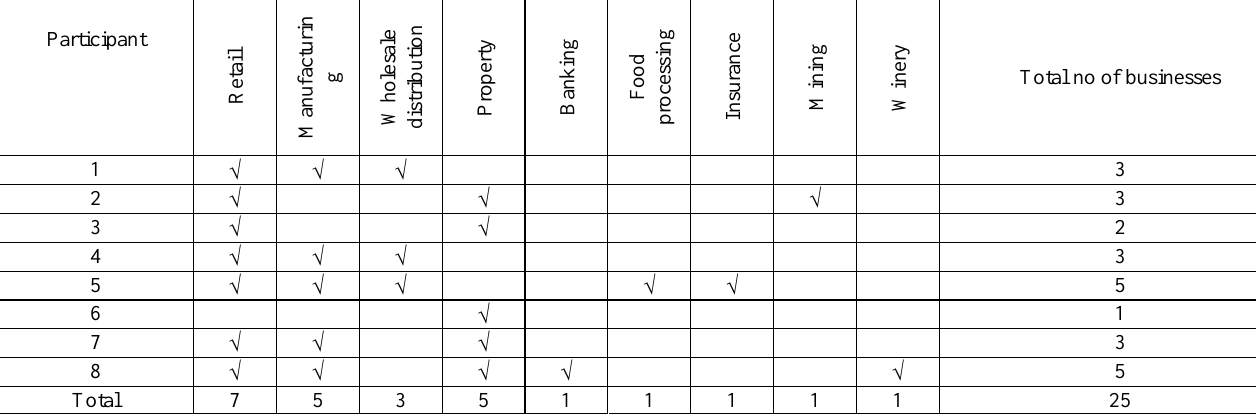
Table 2: Types of businesses the family business groups are involved in Participant